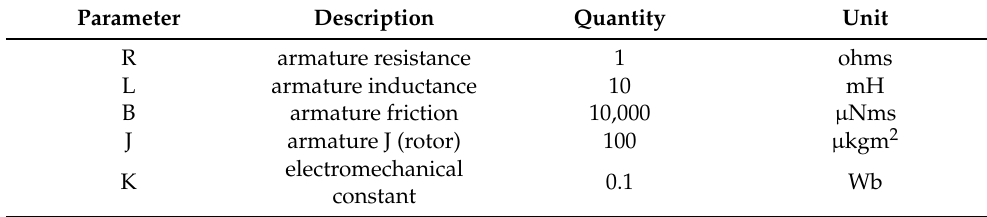
Table 2. DC motor parameters for the case study